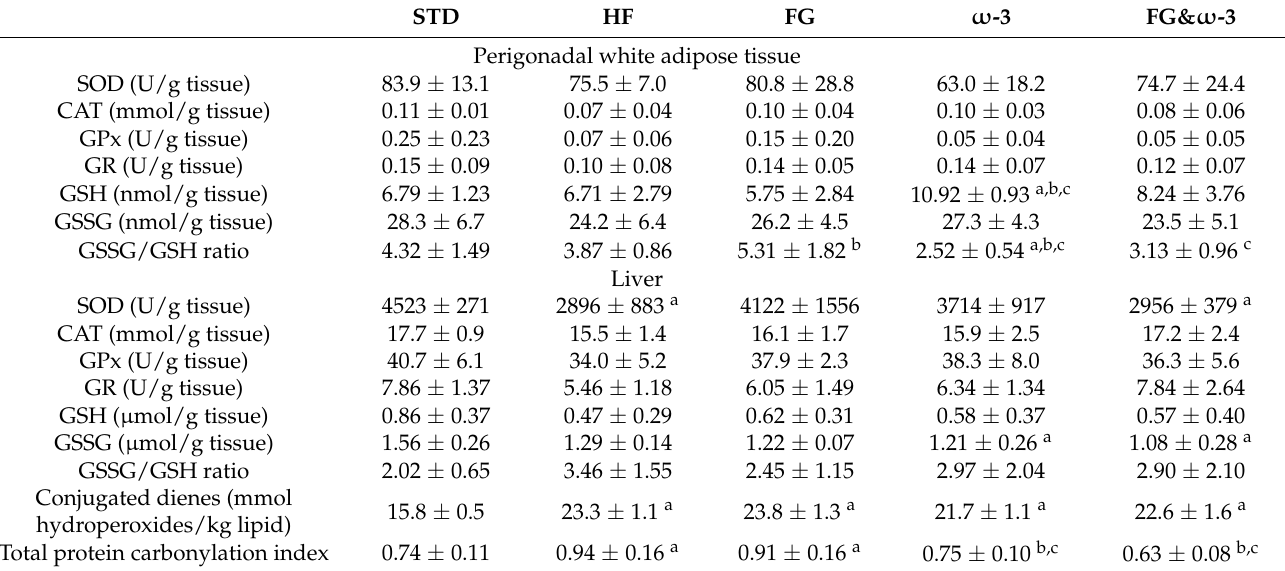
Table 3. Oxidative stress biomarkers in tissues after 21 weeks of dietary